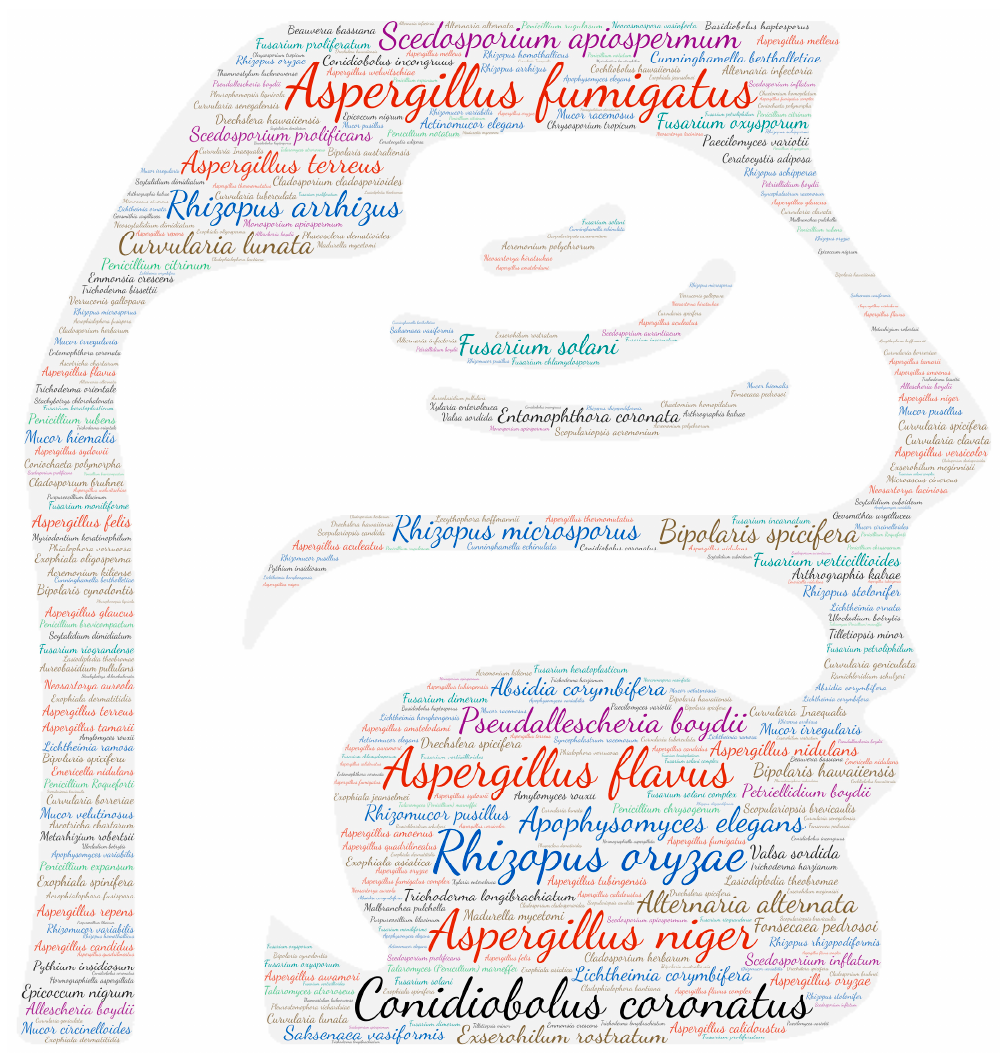
Figure 6. Wordcloud represents the species name isolated in the oto-rhino-laryngeal sphere. The size of the name of each species is proportional to the number of times it occurs in the repertoire.